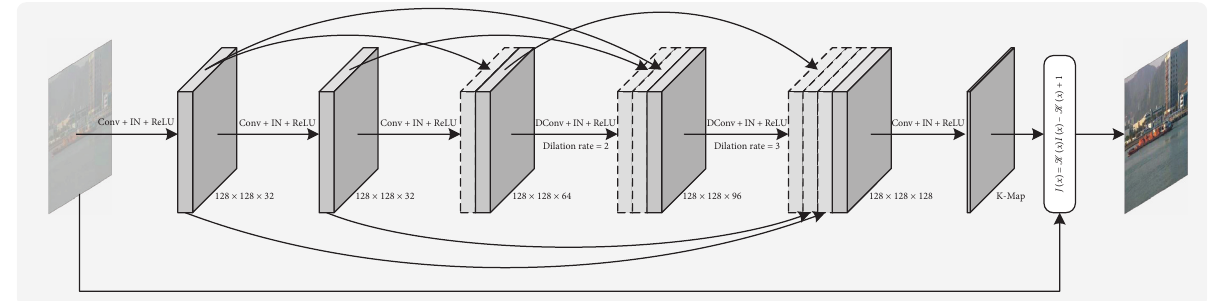
Figure 4: Network architecture of single